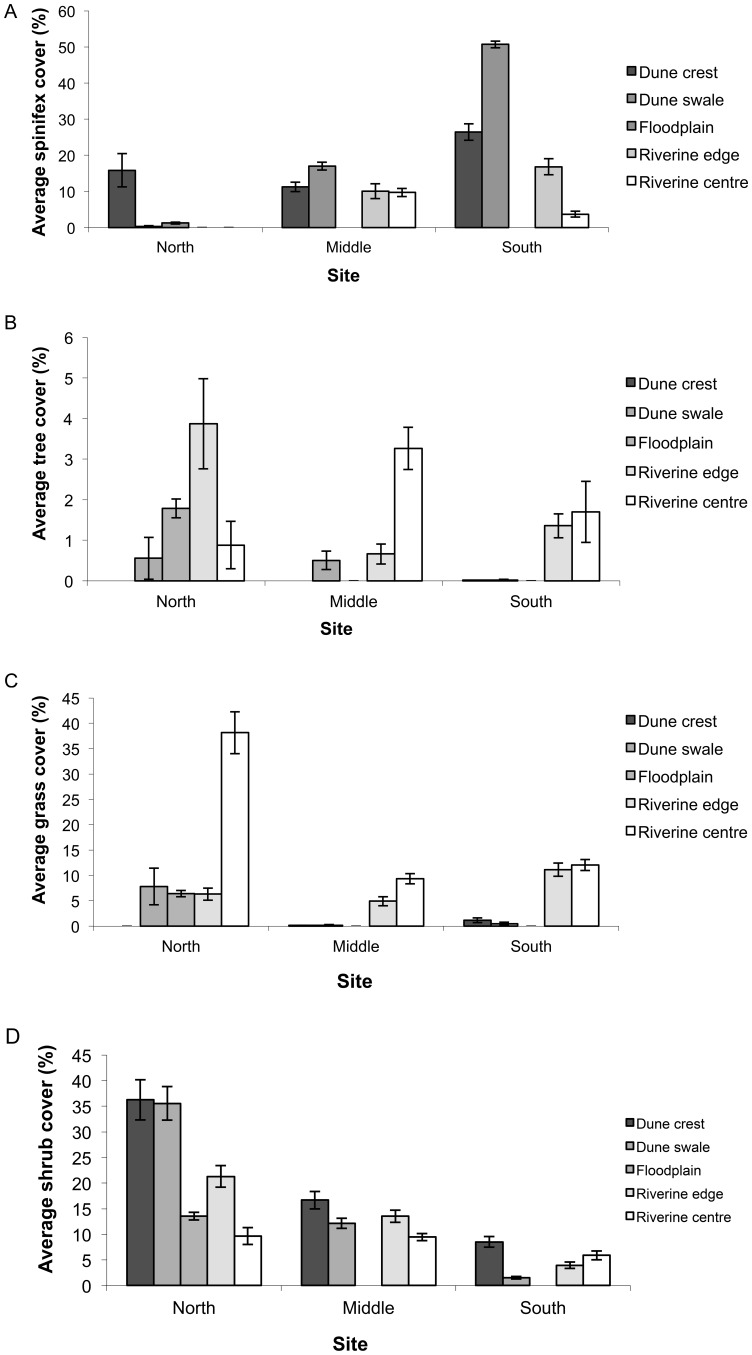
Percentage cover (mean ± s.e.) of (A) spinifex, (B) trees, (C) annual grass, and (D) shrubs at northern, middle and southern study sites in five habitats along the Field River, Simpson Desert, Queensland.In (C), average grass cover over time is shown by the line (right axis).